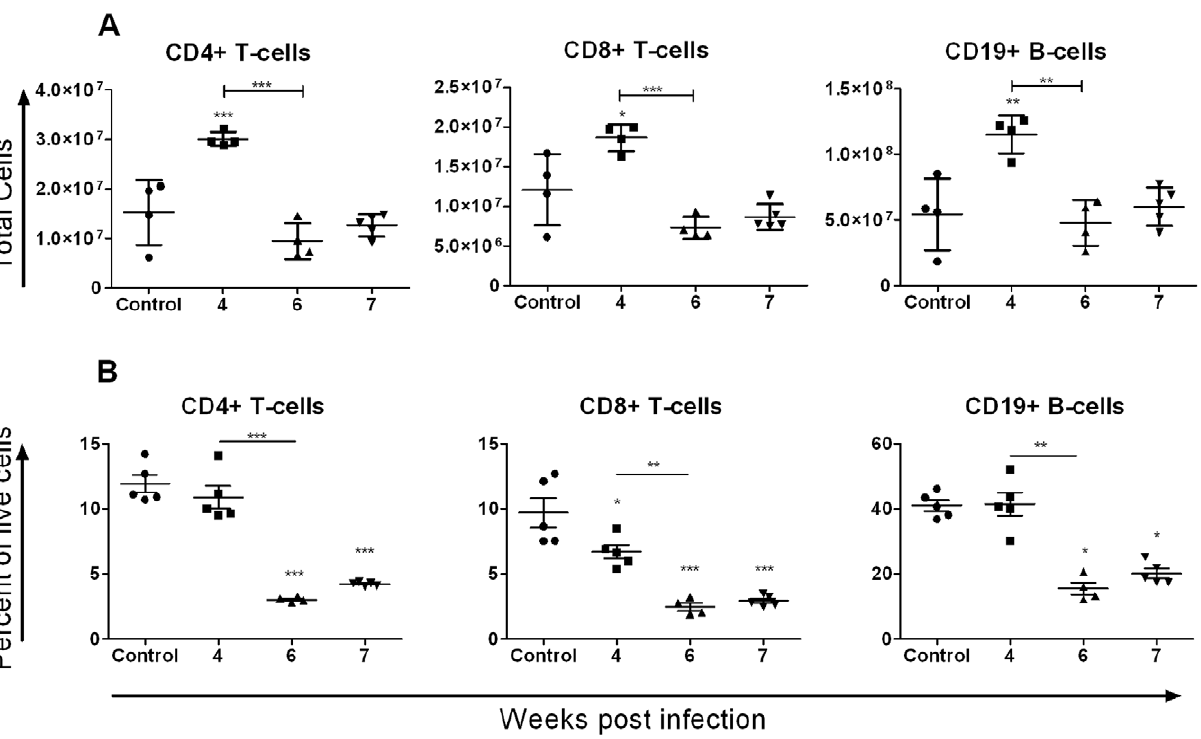
Figure 3. Flow cytometry revealed dynamic changes in lymphocyte populations of the spleen over time. A: Flow cytometry demonstrated a significant increase in the total number of CD4 + and CD8 + T-cells and CD19 + B-cells in the spleen at 4 weeks p.i. followed by return of these cells to baseline levels by 6 weeks p.i. B: The ratio of T- and B-cells to total live cells decreased significantly over time. Values represent means 6 1SD. N=5 per group except for 6 weeks p.i. where one mouse harboured no adult worms and was excluded from all further analyses.